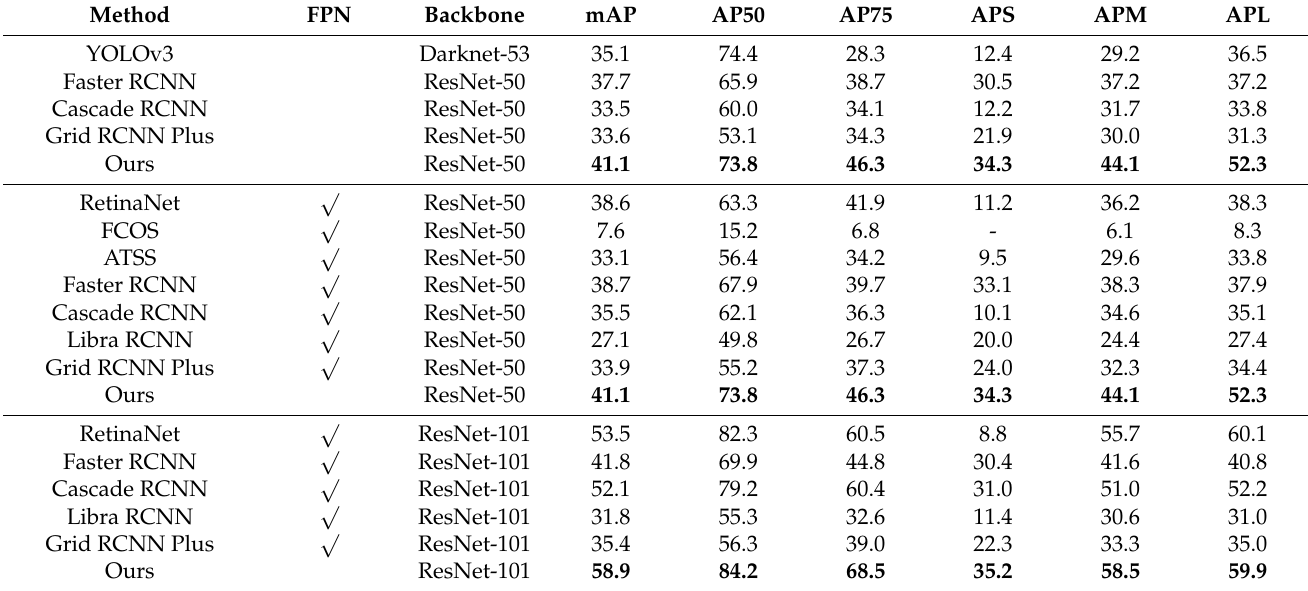
Table 9. Performance Comparison Between DASNet and